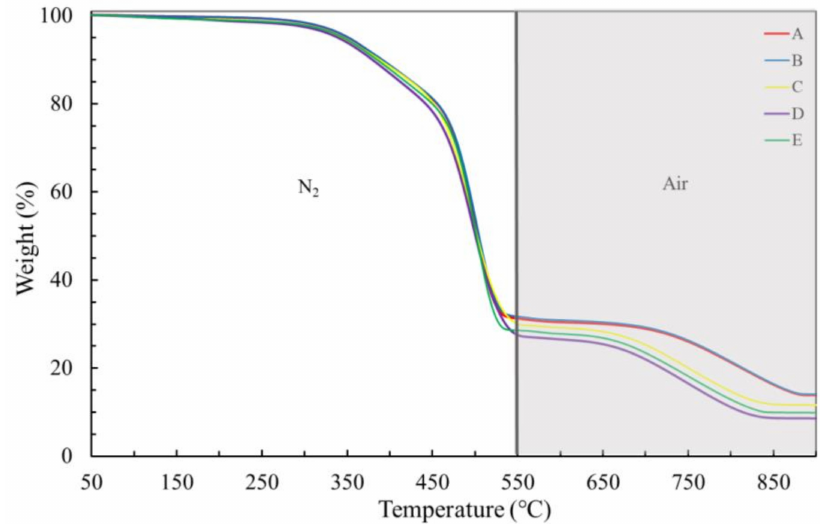
Figure 7. TGA curves of the jacket layer for virgin and naturally aged cables, under condition II (heating rate of 25 ◦ C min − 1 ). A–E stand for different ESP cables as denoted in the Experimental section. Table 5. Weight losses and residues for the cables A–E, evaluated under condition II.